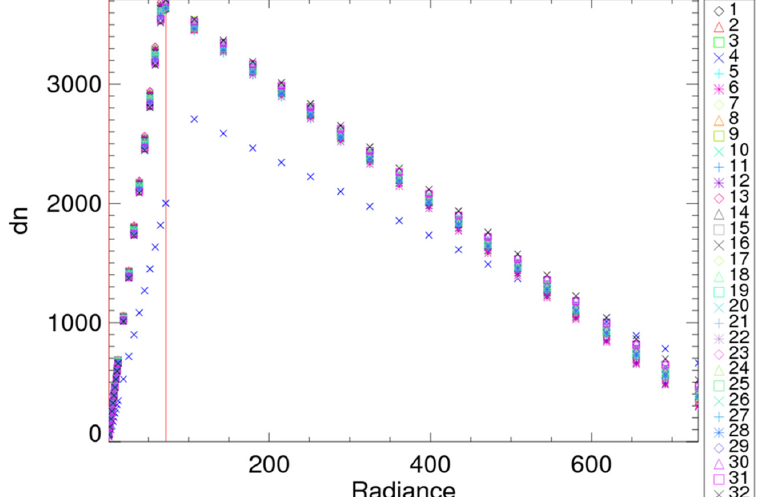
Figure 8. Band I3 dynamic range measurements for all detectors, legend on the right, for HAM side B. The y -axis is offset subtracted VIIRS response, and the x -axis is the SIS100 radiance during the measurement. The vertical red line corresponds to Lmax, and the saturation occurs before the line. The rollover in the response is due to saturation of the focal plane electronics. This causes two unique radiance levels to produce the same VIIRS digital number. The blue crosses are from detector 4 that is an out of family with degraded performance that has continued on orbit.